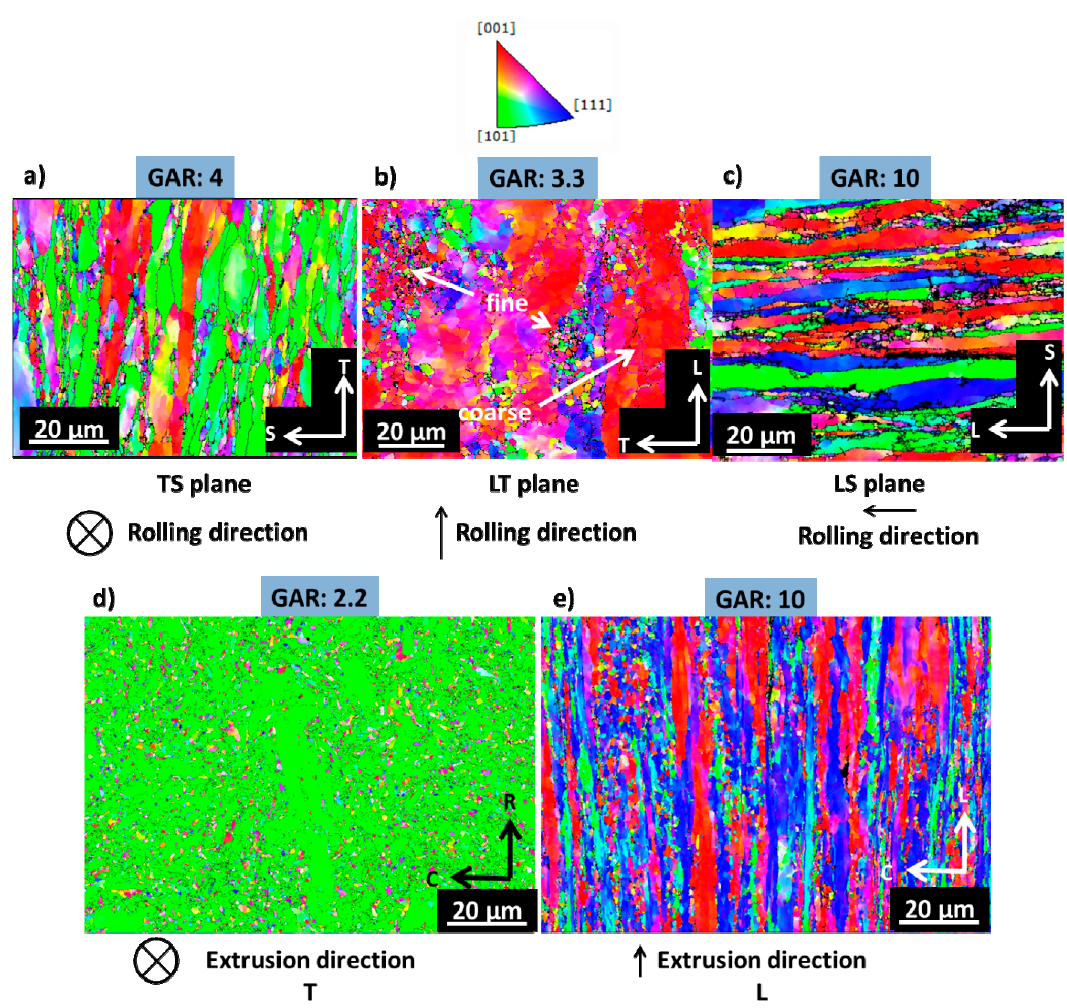
Figure 4. Inverse pole figure Z maps of ODS-KIT HR in ( a ) TS ( b ) LT and ( c ) LS plane and ODS-KIT HE in ( d ) transversal plane (T) and ( e ) longitudinal plane (L) (10° misorientation angle threshold). Indicated GAR values are for coarse grains.